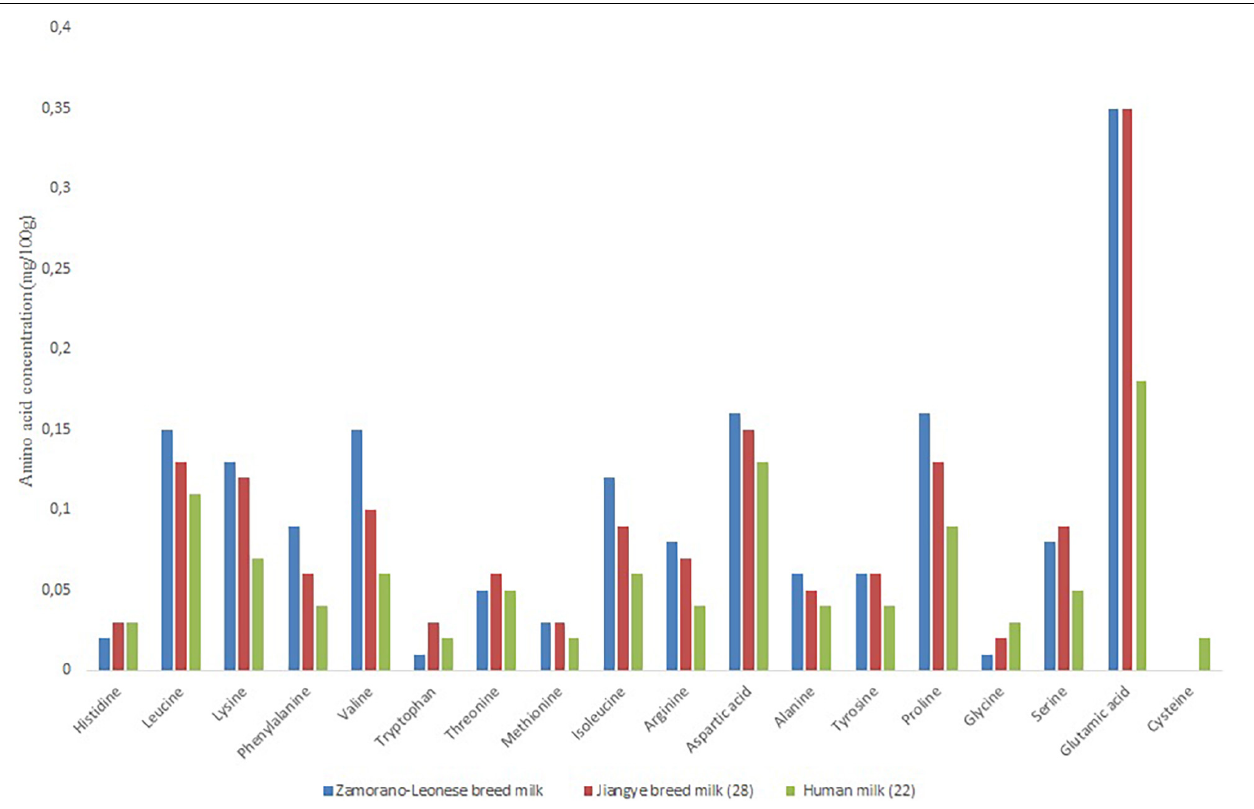
FIGURE 3 | Amino acid concentration (mg/100 g of milk) of Zamorano-Leonese breed milk in comparison with Jiangye breed milk (28) and human milk (22).